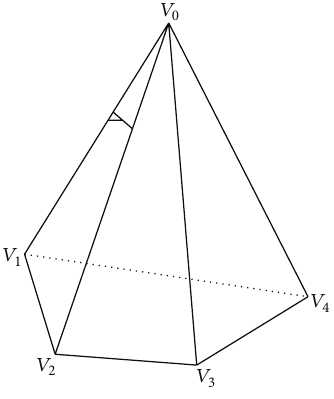
Figure 1: Triangular mesh in STL